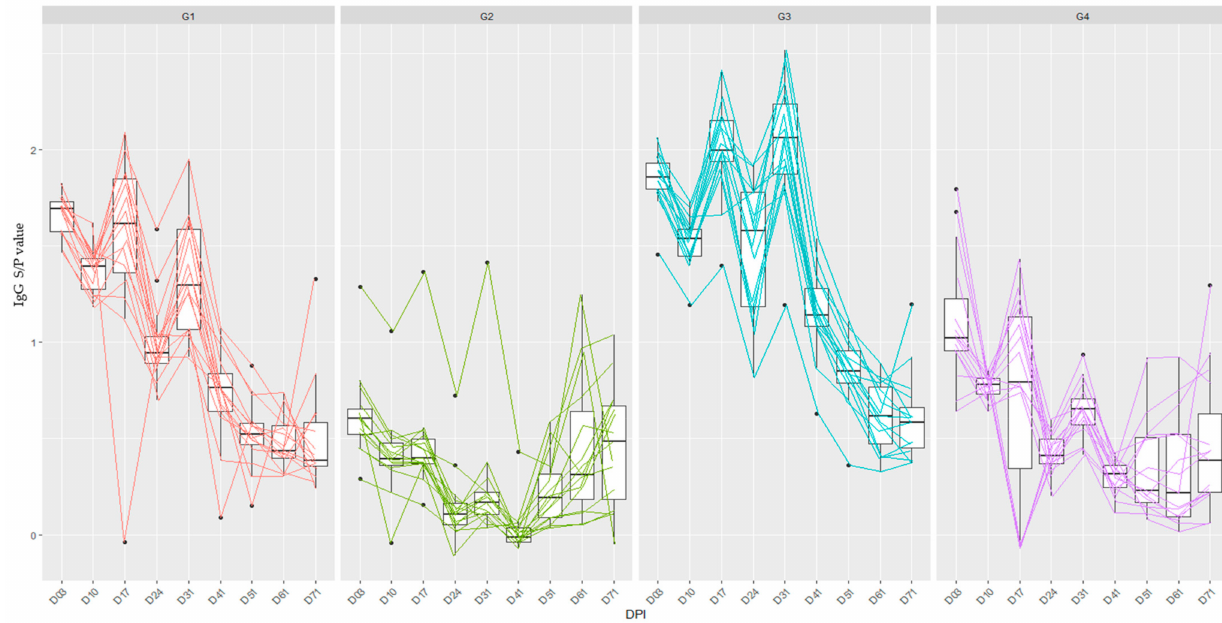
Figure 2. Parallel coordinates boxplots of S/P values for IgG anti- M. hyopneumoniae recorded over time considering animals from G1 to G4. The lines in a parallel coordinates plot represent the trajectories of observations across different time points. The bold dots indicate the